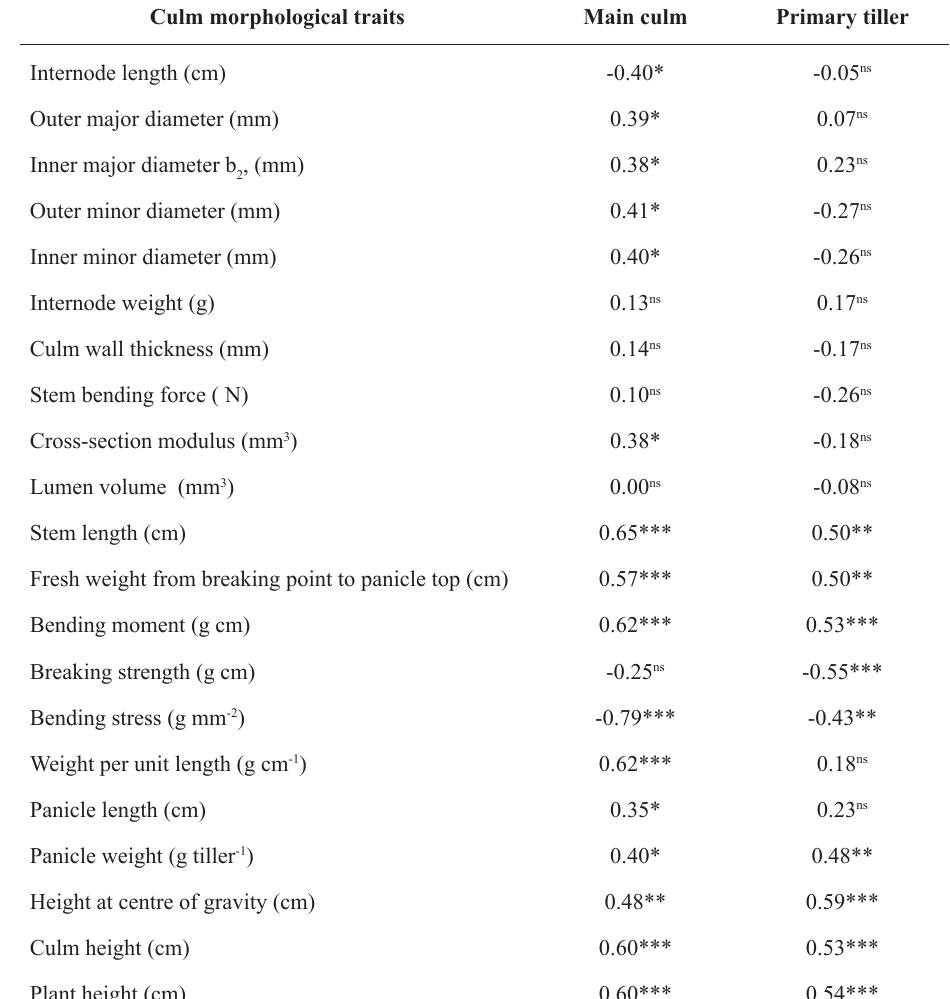
Table 4: Pearson’s product moment correlation coefficients of culm morphological traits with the lodging index of the main culm and the primary tiller of upland rice across rates of nitrogen